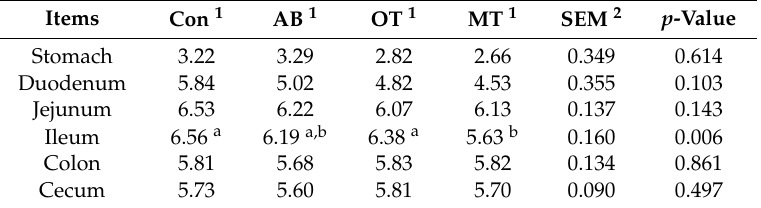
Table 4. E ff ect of dietary supplementation with tributyrinin combination with di ff erent essential oils on pH value of the gastrointestine of weaned pigs.